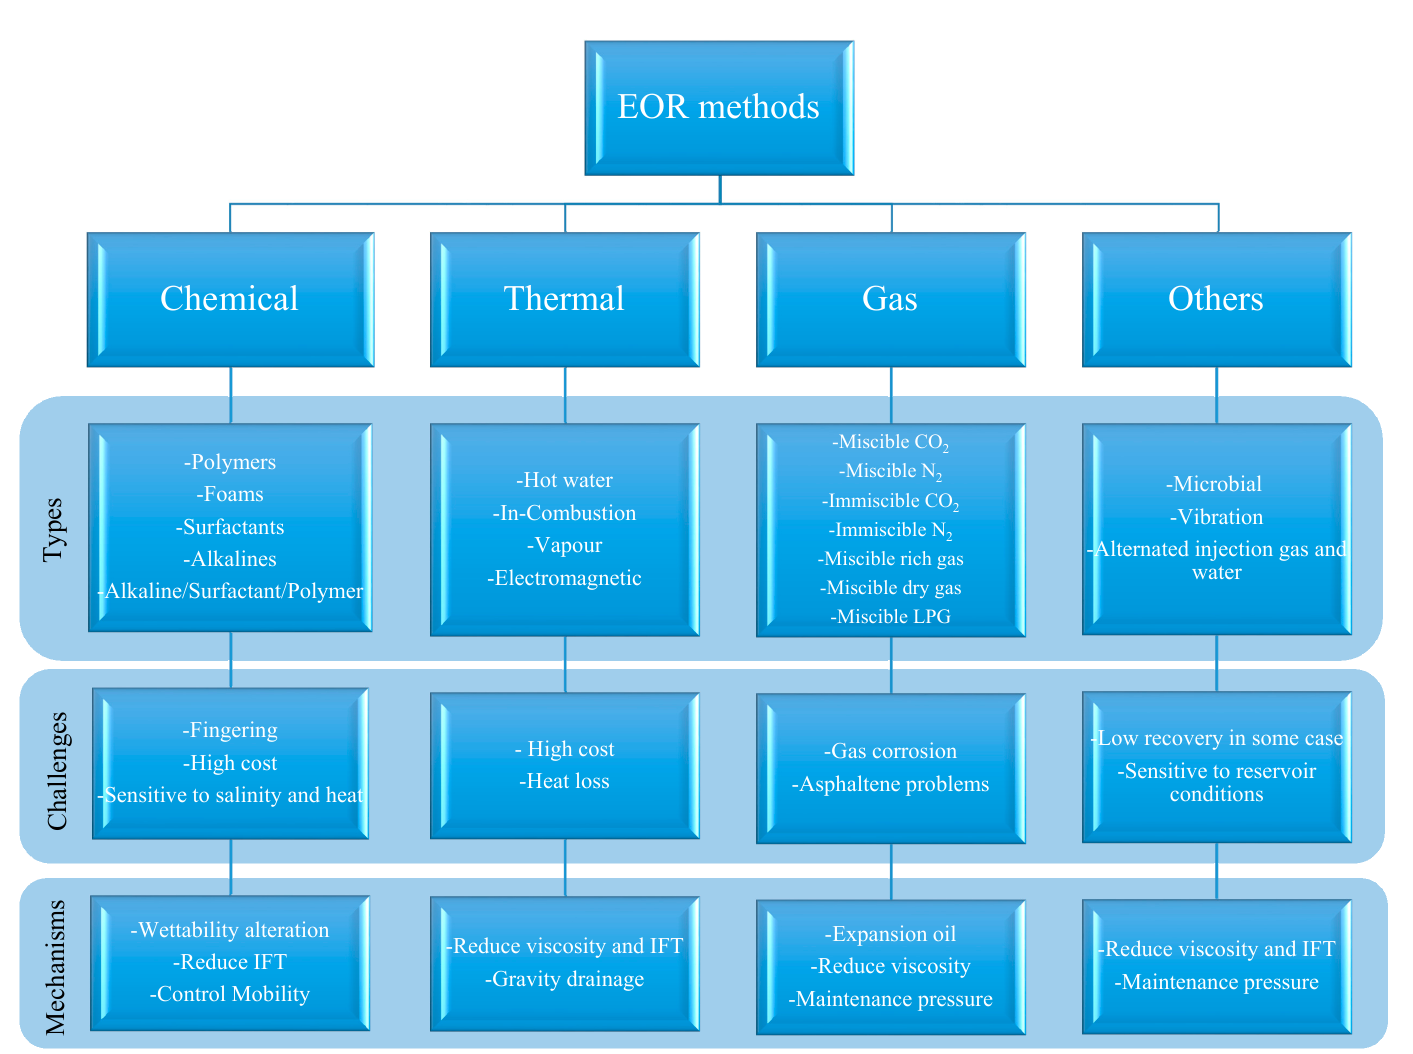
Figure 1. Flow sheet of enhanced oil recovery methods, mechanisms and